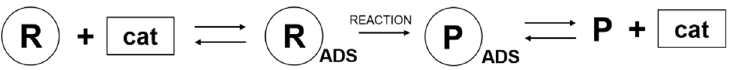
Figure 1. The catalytic cycle, ([ADS] = physically or chemically adsorbed).